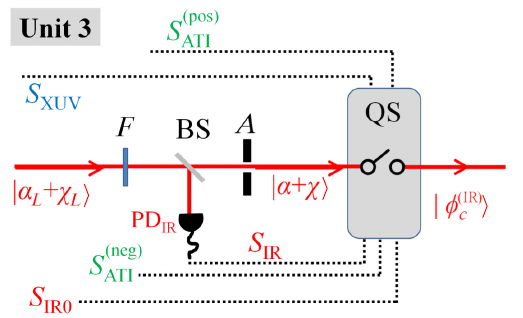
FIG. 12. A schematic illustration of unit 3. Here F , BS, and A respectively represent a neutral density filter, a beam splitter, and an aperture; PD IR is an IR photodetector; S XUV , S